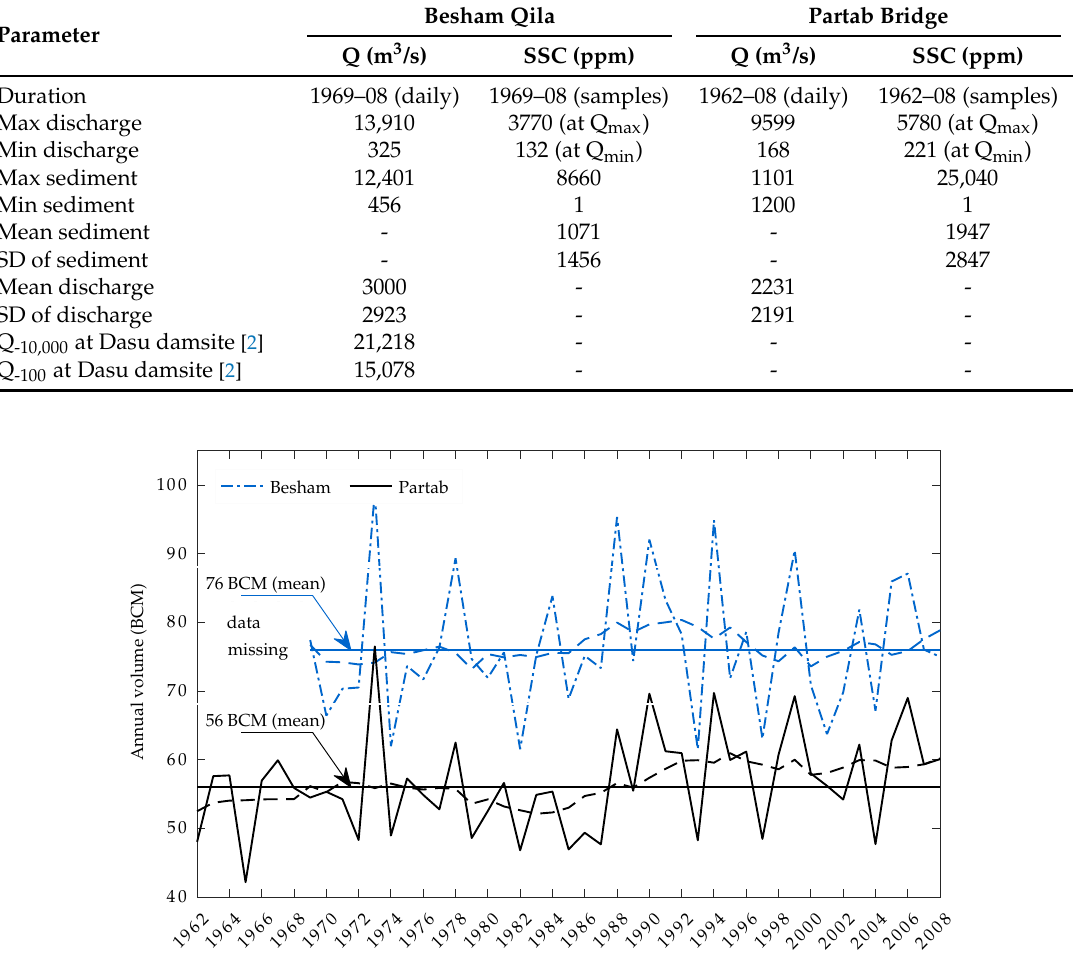
Figure 2. Hydrograph showing actual and smoothed flows with 10-year moving average (dashed lines) in billion m 3